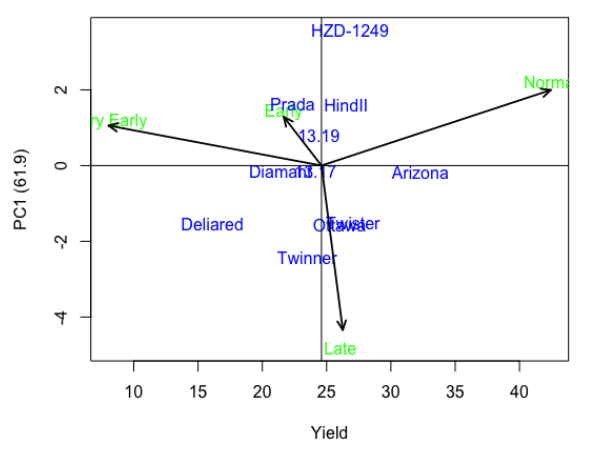
Figure 3: AMMI 1 biplot of 11 potato genotypes evaluated in four planting dates for marketable tubers(tha -1 ) at Debiganj, Panchagarh,